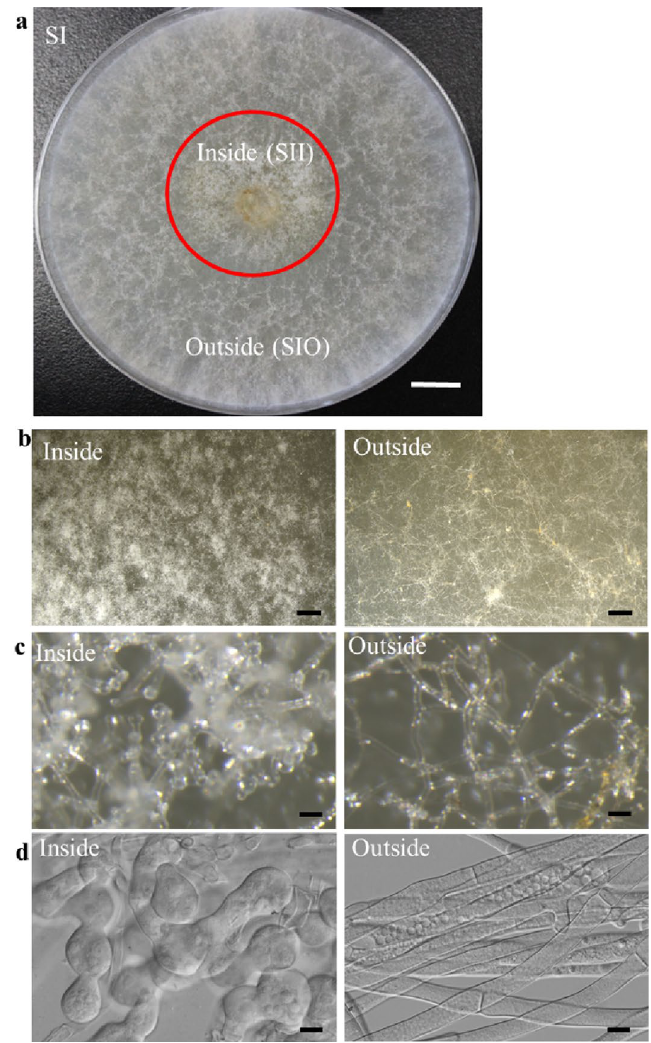
Figure 1. Morphological observation of SII and SIO cells cultured on PDA medium. ( a ) Colony morphology of M. importuna cells grown on PDA plates at SI stage. An area of 2 cm radius around the center which was circled with red was divided as the inside, and the remaining of the plate was divided as the outside area. There was distinct boundary. Size bar = 1 cm. ( b ) Magnified pictures of colonies of SII and SIO. Size bars = 1 mm. ( c ) Sclerotium observation in SII and SIO under the stereoscope. Size bars = 30 µm. ( d ) Cell morphology of M. importuna in SII and SIO at SI stage. Size bars = 10